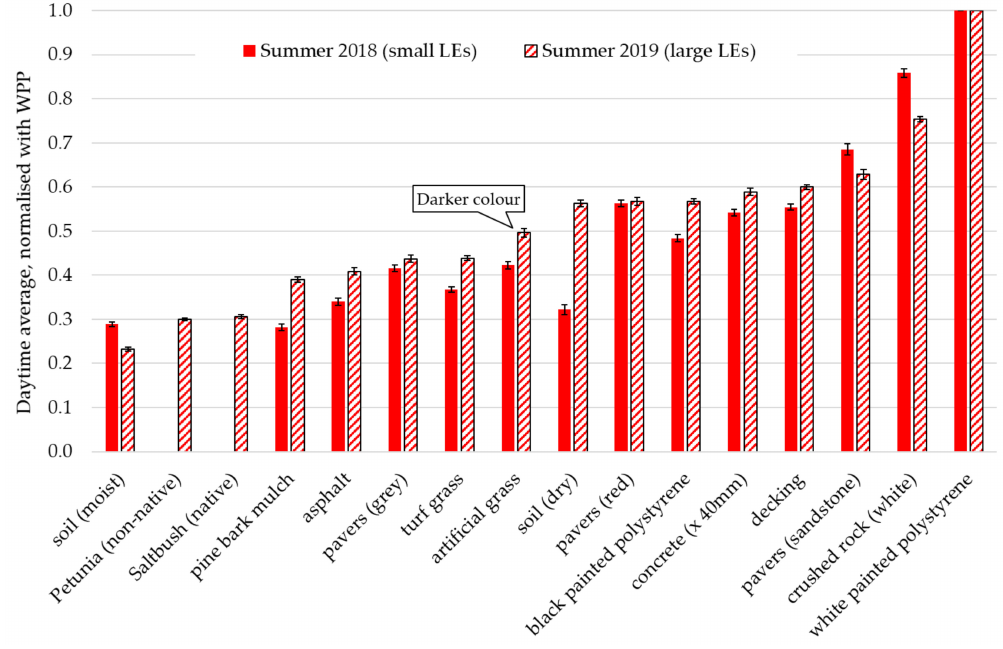
Figure 13. Comparison of relative total radiation of LEs when normalised with white painted polystyrene. Summer 2018 and summer (21st January) 2019 DR av (day − time) comparison of size and ground coupling of similar LEs. Uncertainties are the standard errors